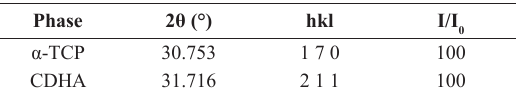
Table 2. Selected peaks from α-TCP (JCPDS 09-0348) and CDHA (JCPDS 46-0905).